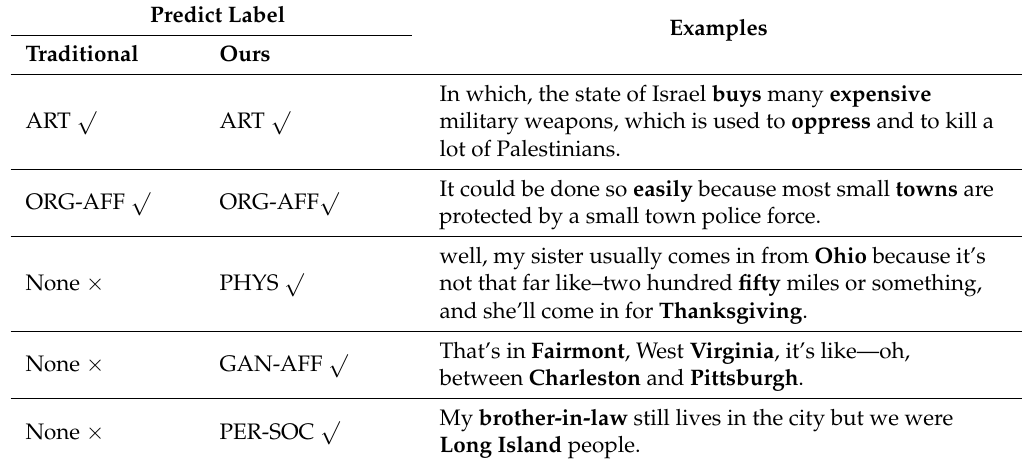
Table 6. Some predictions of typical samples comparison. We use DANN and CVAN as traditional models. The words with bold are